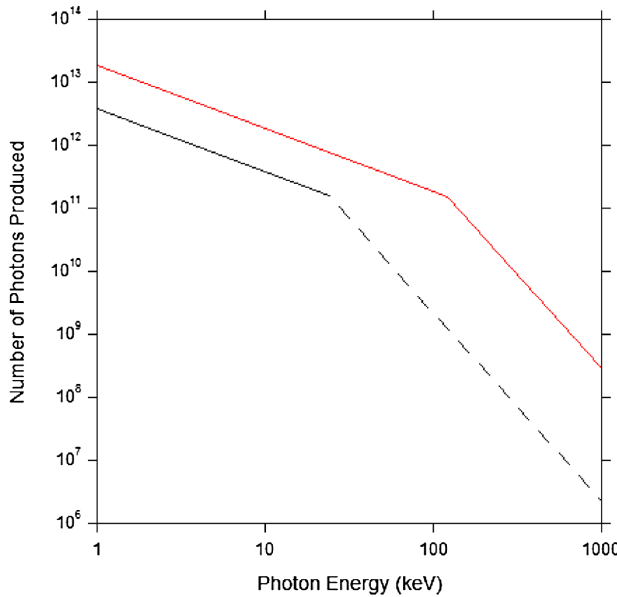
FIG. 1. Rough scaling of photons per pulse versus photon energy for conventional technology (black) and from using eigenemittance partitioning (red). The scaling for conventional technology is dashed beyond 10 keV, due to uncertainty in the CSR model’s validity for ultrashort bunches in the